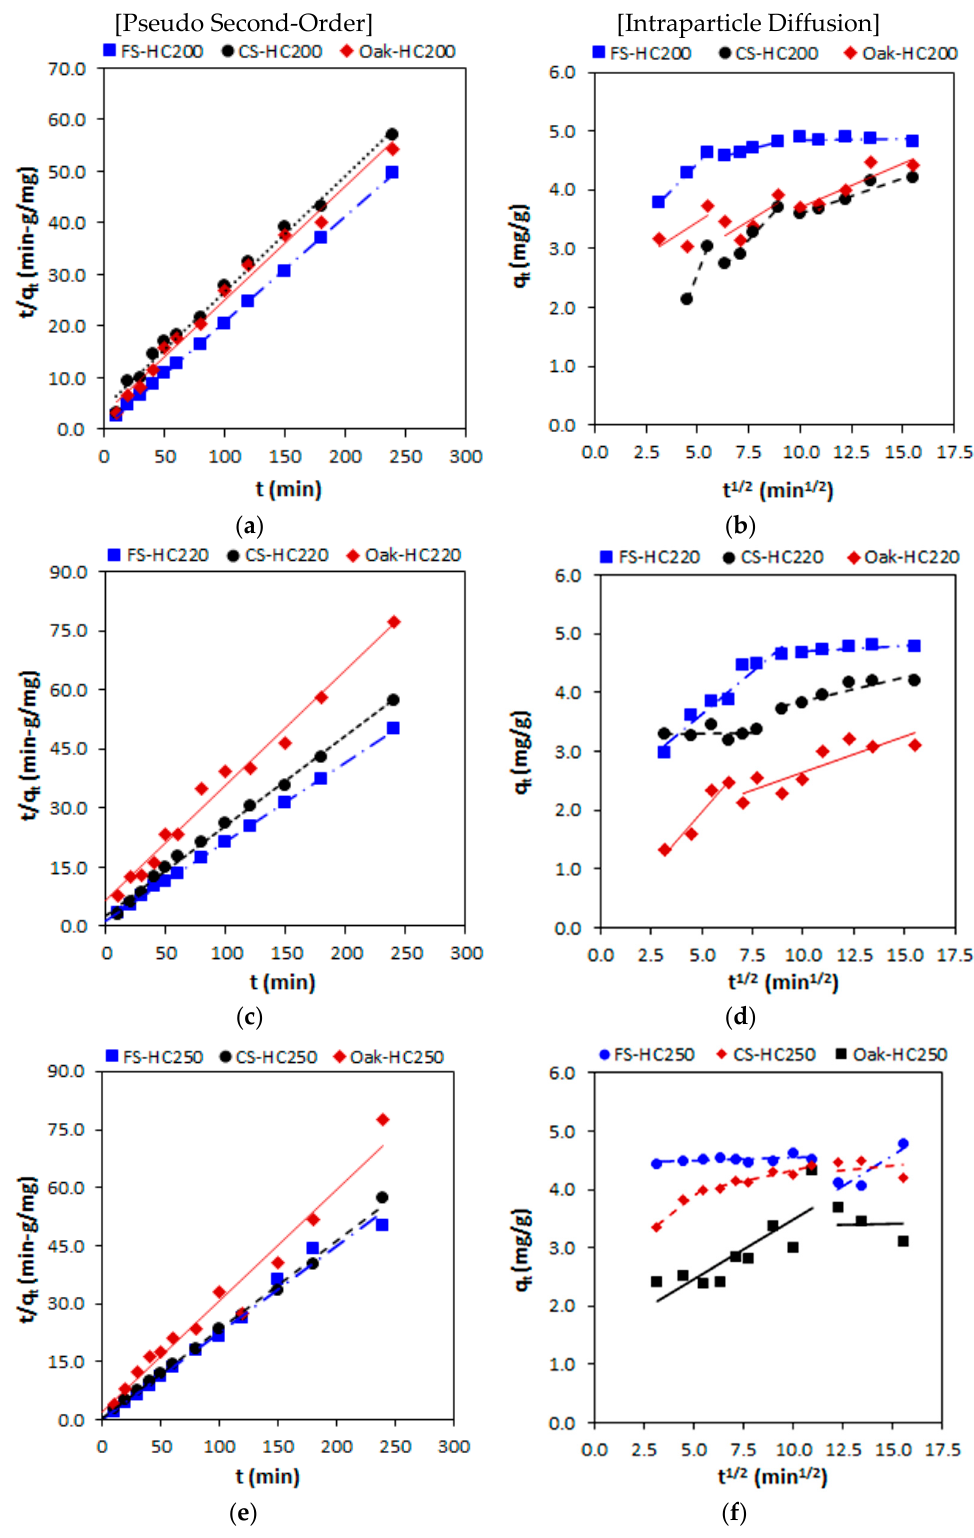
Figure 5. Pseudo second-order ( a – c ), and intraparticle diffusion ( d – f ) adsorption kinetic models of MB dye on FS-HCs, CS-HCs, and Oak-HCS produced at ( a , d ) 200 ° C; ( b , e ) 220 ° C; and ( c , f ) 250 ° C.